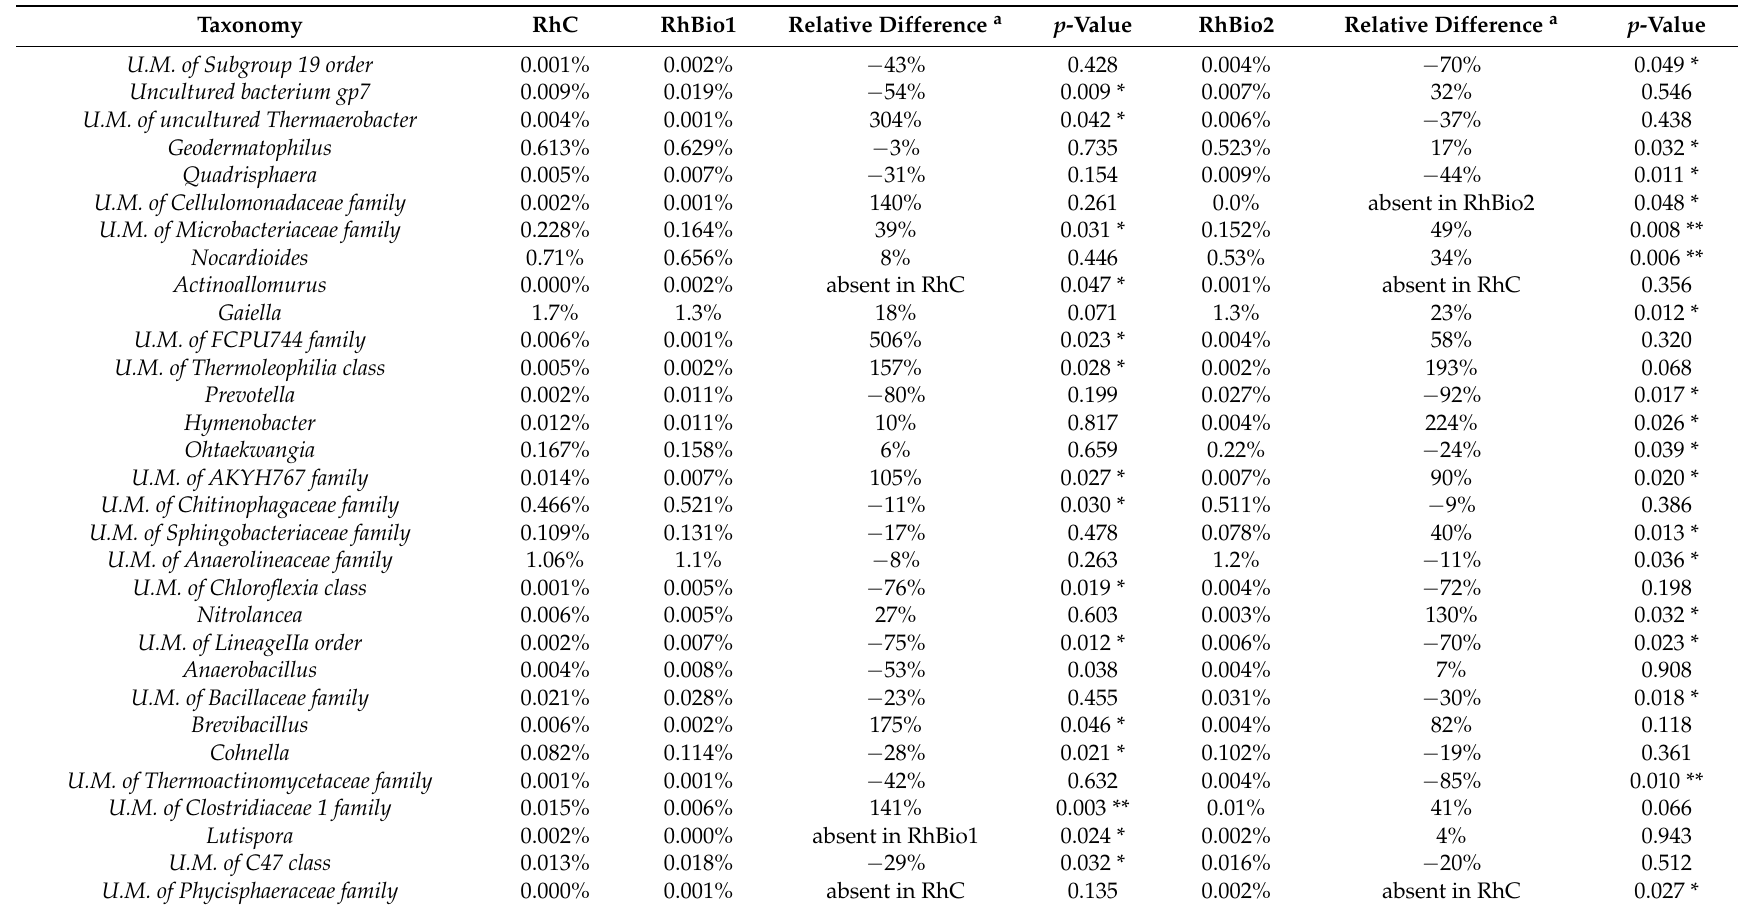
Table 3. The bacterial taxa at the Carignano site with significant variations ( p -value ≤ 0.05) in the rhizosphere of maize plants grown from seeds treated with Biostiumant 1 and Biostimulant 2 compared with untreated controls. Data reported are presented as the percentages of the abundance of the mean values of 4 biological